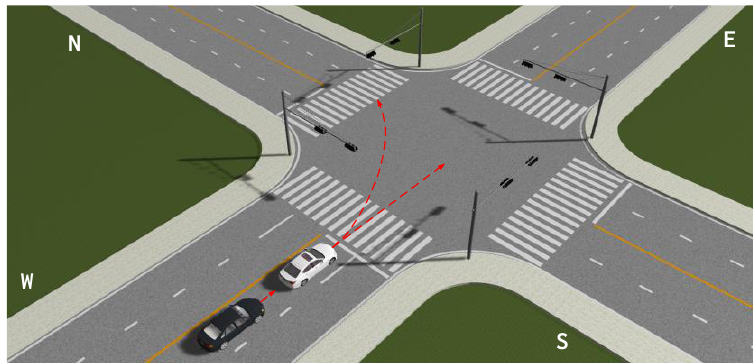
Figure 1. The scene of a vehicle entering the intersection.